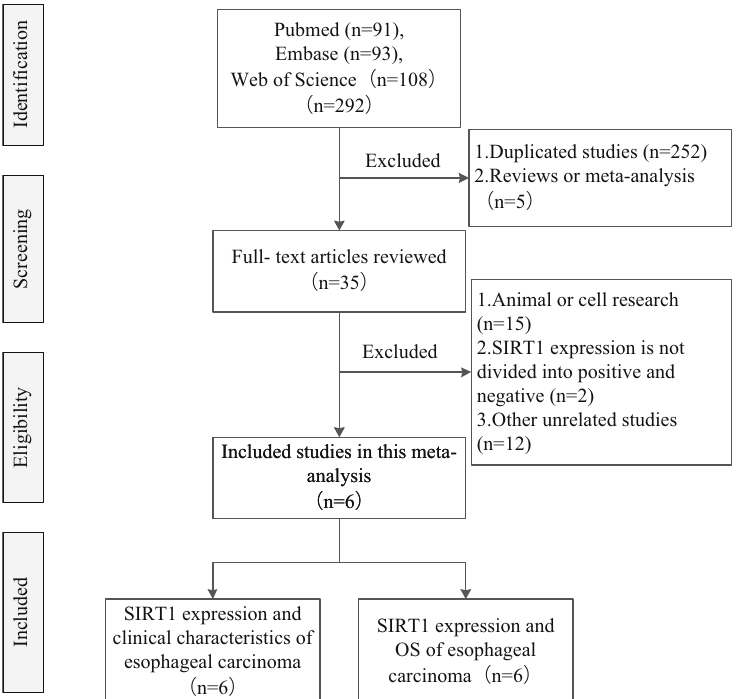
e ff ect variable. The SIRT1 expression was a little lower in medium and high di ff erentiation than that in low di ff er - entiation of ESCC ( OR = 1.01, 95% CI: 0.72 – 1.43 ) , but the di ff erence was not statistically signi fi cant ( Z = 0.09, P = 0.93 ) , ( Figure 3 ) . No signi fi cant publication bias was observed ( t = 1.73, P = 0.16 ) .